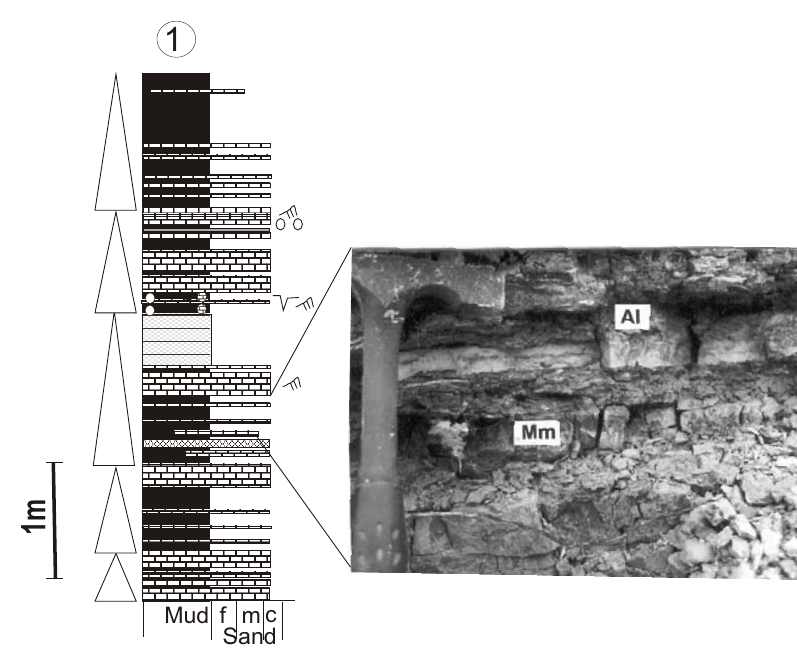
Fig. 5 – A lithostratigraphic profile recording thin layers of limestones interbedded with argillites (see photographfordetail, whereMm=mudstoneandAl=laminatedargillite), whicharearrangedintoseveral shallowing-upward cycles (arrows) in a subaqueous environment with frequent exposure to meteoric and/or vadose conditions. (Hammer head for scale = 15 cm long). (See figure 2 for